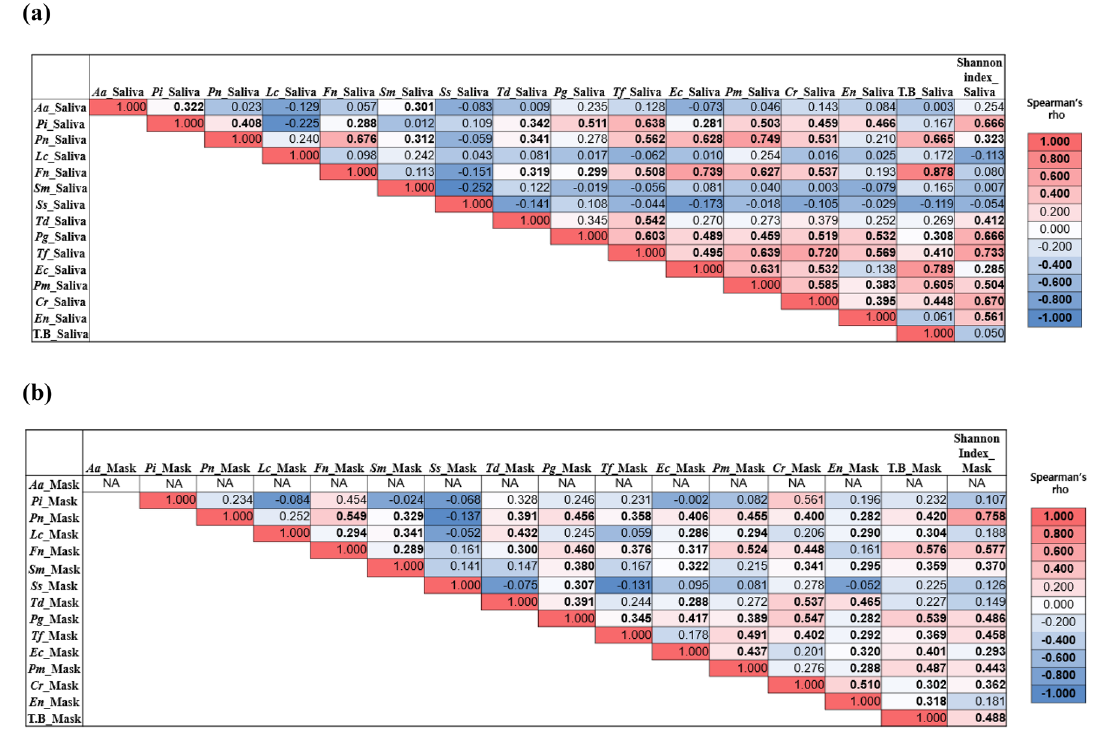
Figure 4. Bacterial correlation in ( a ) saliva and ( b ) mask samples. Aa: Aggregatibacter actinomycetemcomitans; Pi: Prevotella intermedia; Pn: Prevotella nigrescens; Lc: Lactobacillus casei; Fn: Fusobacterium nucleatum; Sm: Streptococcus mutans; Ss: Streptococcus sobrinus; Td: Treponema denticola; Pg: Porphyromonas gingivalis; Tf: Tannerella forsythia; Ec: Eikenella corrodens; Pm: Parvimonas micra; Cr: Campylobacter rectus; En: Eubacterium nodatum; T. B: total bacterial DNA copy numbers. NA: not applicable; Aa was not detected on the inner surface of the mask, and we could not examine the correlation between Aa_Mask and other bacteria.